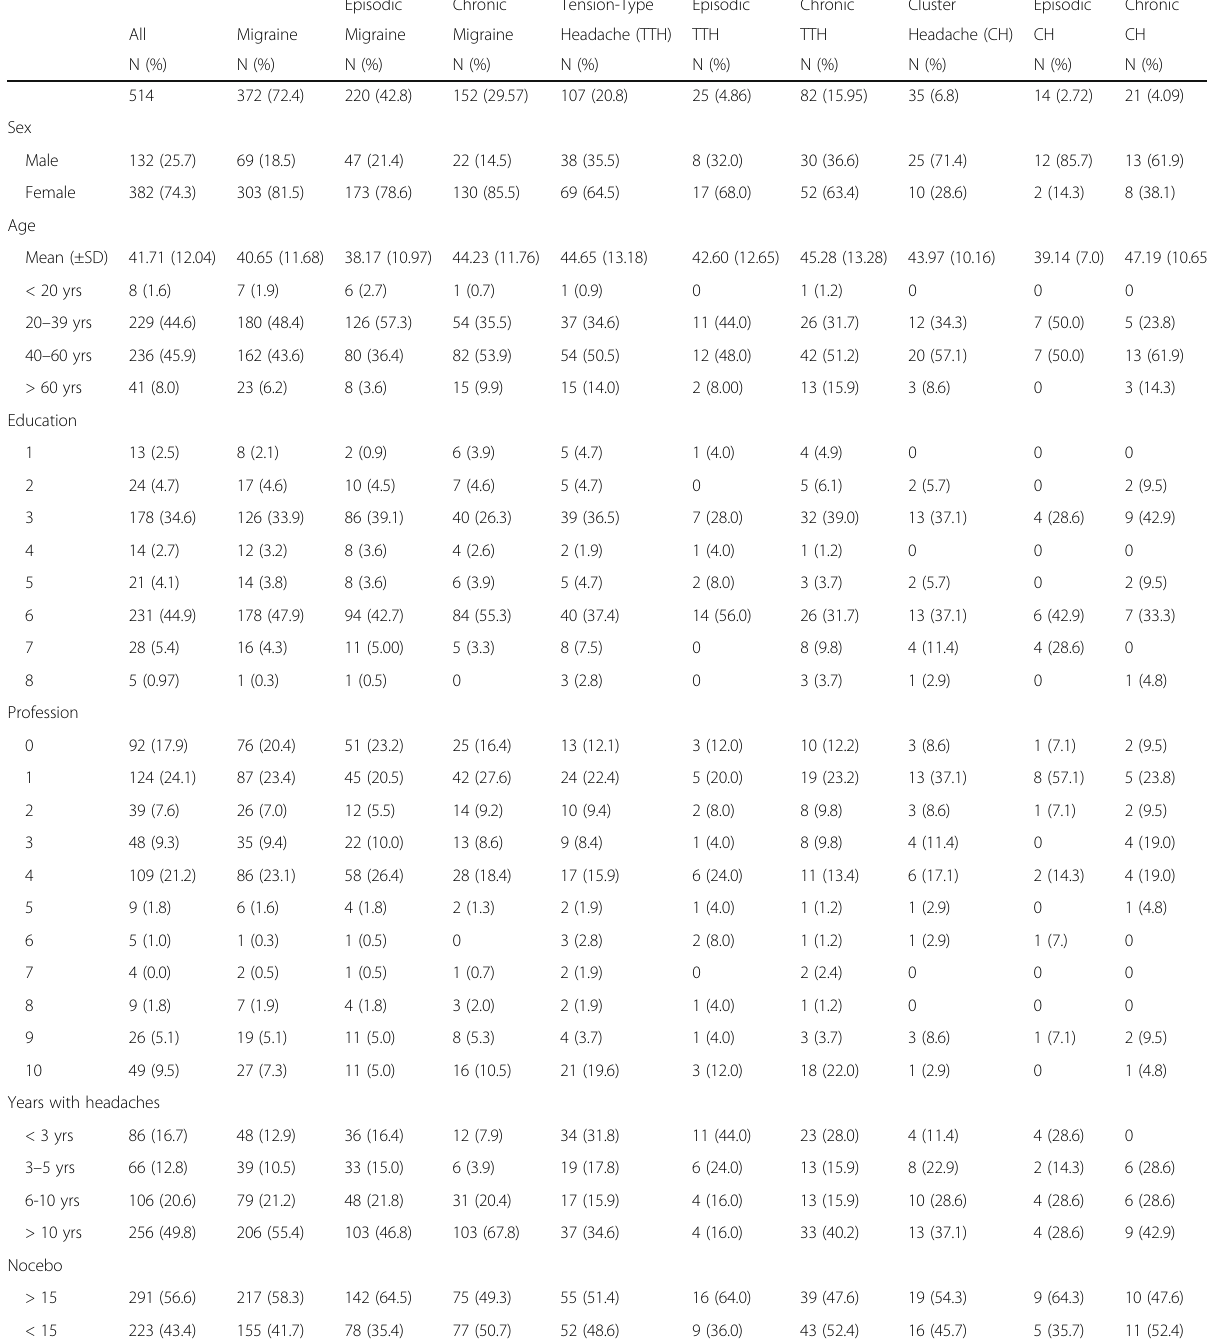
Table 1 Demographic characteristics of participants by their primary headache syndrome Episodic Chronic Tension-Type Episodic